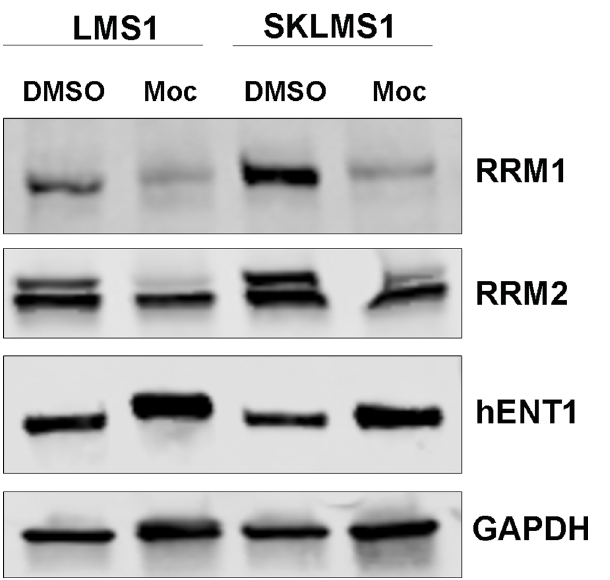
Fig 4. Mocetinostat regulates gemcitabine-resistant markersexpression. Mocetinostat reduces RRM1 and RRM2, and increaseshENT1 expressionin LMS cell